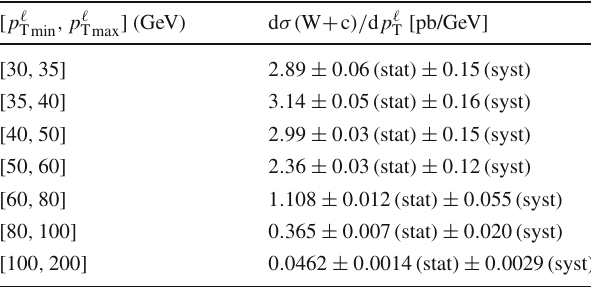
Table8 Measureddifferentialcrosssectionasafunctionof p (cid:3) c )/ d p (cid:3) from the combination of all four channels T